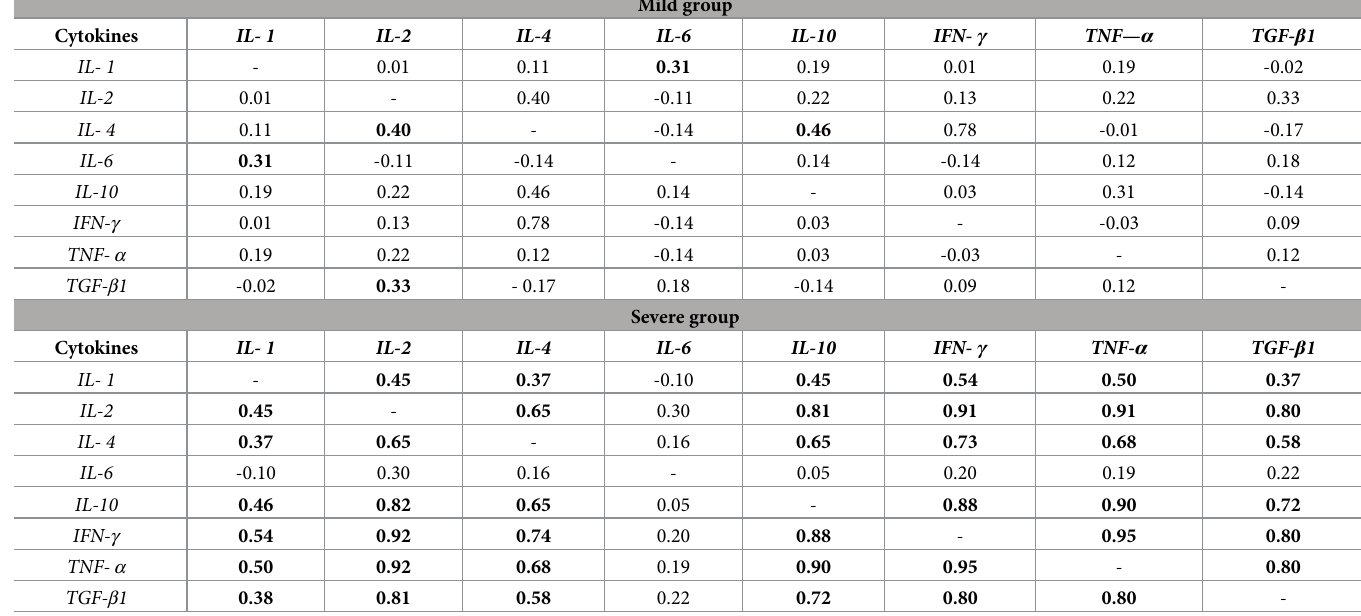
Table 2. Correlation between cytokine expressions in the mild and severe groups. Each column shows the coefficient of correlation (r). Correlations with significant p- values (p < 0.05) are shown in